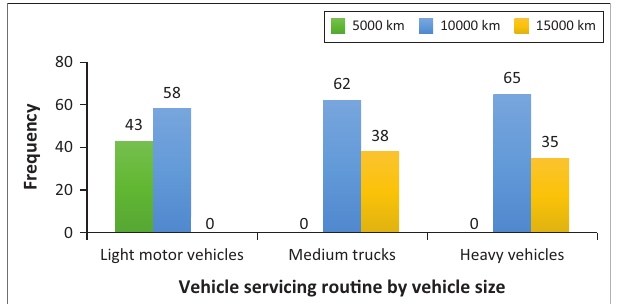
FIGURE 7: Vehicle fleet servicing routines.